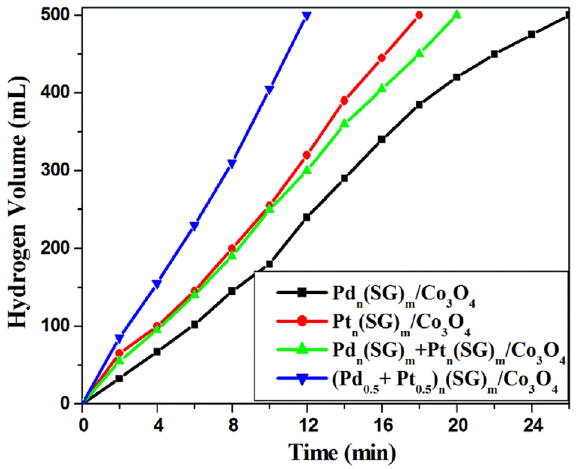
Figure 6. Hydrogen generation from NaBH 4 hydrolysis over the prepared catalysts. Reaction conditions: 1 g of NaBH 4 in 100 H 2 O; catalyst, 5 mg; at 25 °C.